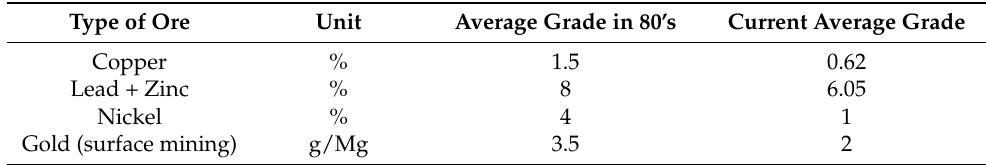
Table 5. World average grades of selected ore minerals